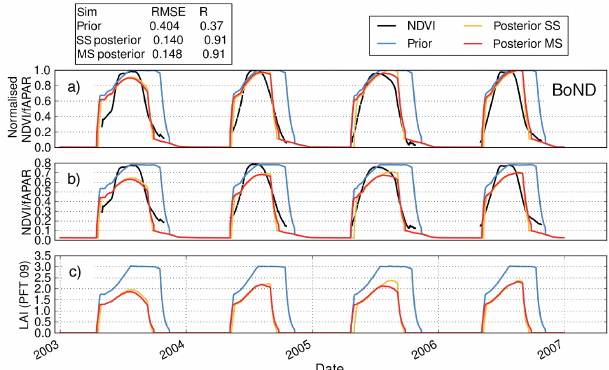
Figure 3. Time series (zoom to 2003–2007) for one example BoND PFT site (72 ◦ N, 120.24 ◦ E) of (a) the normalised modelled total fA- PAR and MODIS NDVI data; (b) the un-scaled model total fAPAR and MODIS NDVI data; (c) the corresponding modelled LAI for the BoND PFT only. The black curve corresponds to the MODIS NDVI data, the blue curve is the prior model simulation, the orange curve shows the model simulation using the posterior parameters from the SS optimisation, and the red curve corresponds to the model sim- ulation at this site using the MS posterior parameter values. The prior and posterior RMSE and R are given in the upper left box. The MODIS NDVI and model fAPAR time series were normalised to their maximum and minimum value over the 2000–2008 period for the optimisation (see Sect.